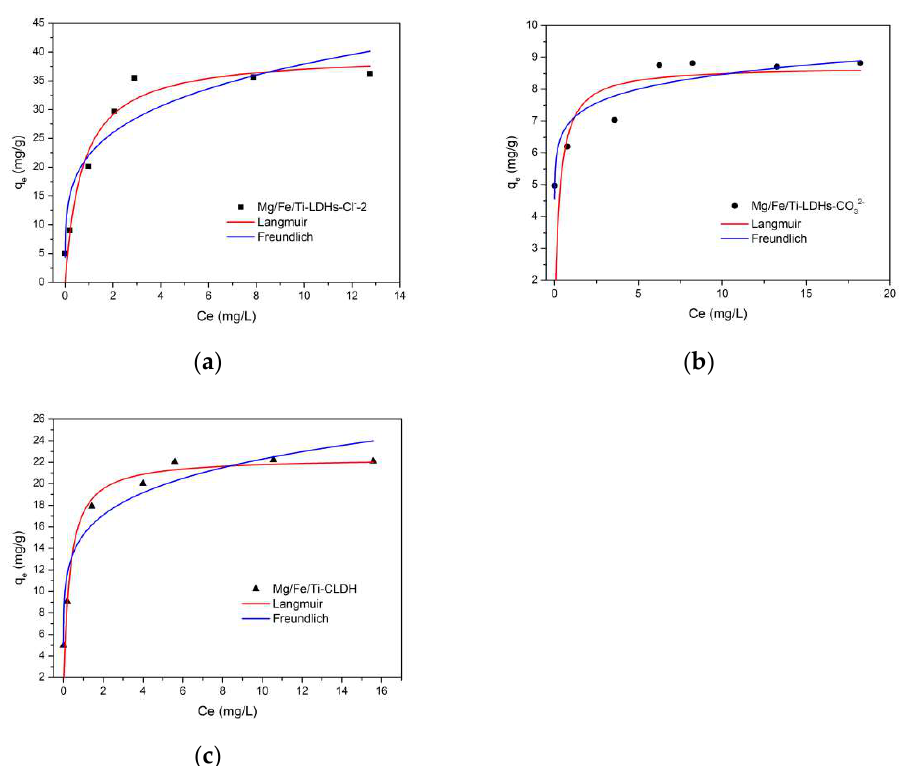
Figure 7. Adsorption isotherms of vanadate on the synthesized Mg − Fe − Ti − LDHs − Cl — − 2 ( a ), Mg − Fe − Ti − LDHs − CO 32− ( b ) and Mg − Fe − Ti − CLDH ( c ) (experimental conditions: C 0 = 1–20 mg/L, adsorbent dosage = 10 mg, pH = 5.0, contact time = 24 h, T = 298 K).